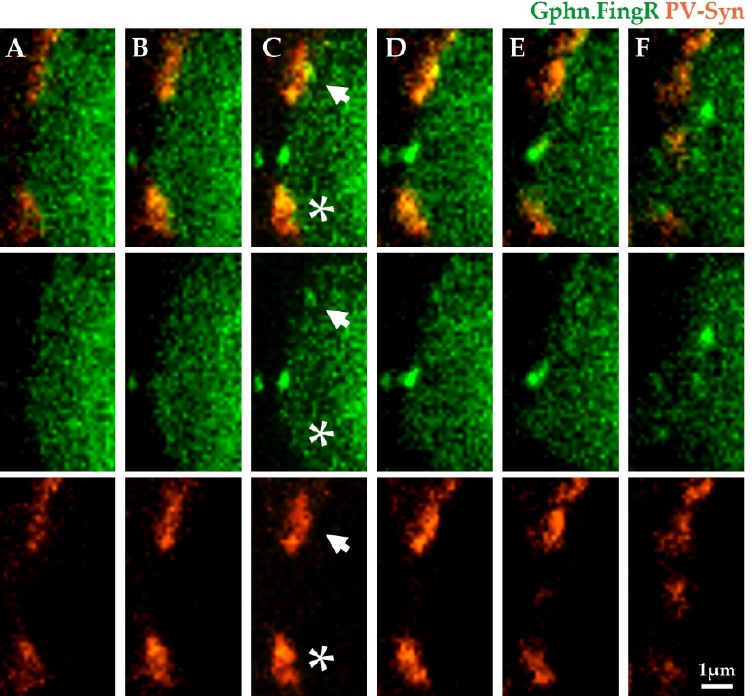
Figure 4. A subset of PV boutons on Pyr neuron somas lack gephyrin. ( A – F ) Serial optical sections from a single Pyr neuron’s soma with Gephyrin.FingR (green) and PV-Syn (orange); arrows mark bouton associated with Gephyrin.FingR, asterisks mark bouton lacking postsynaptic Gephyrin.FingR. Nucleus is at right in the image.